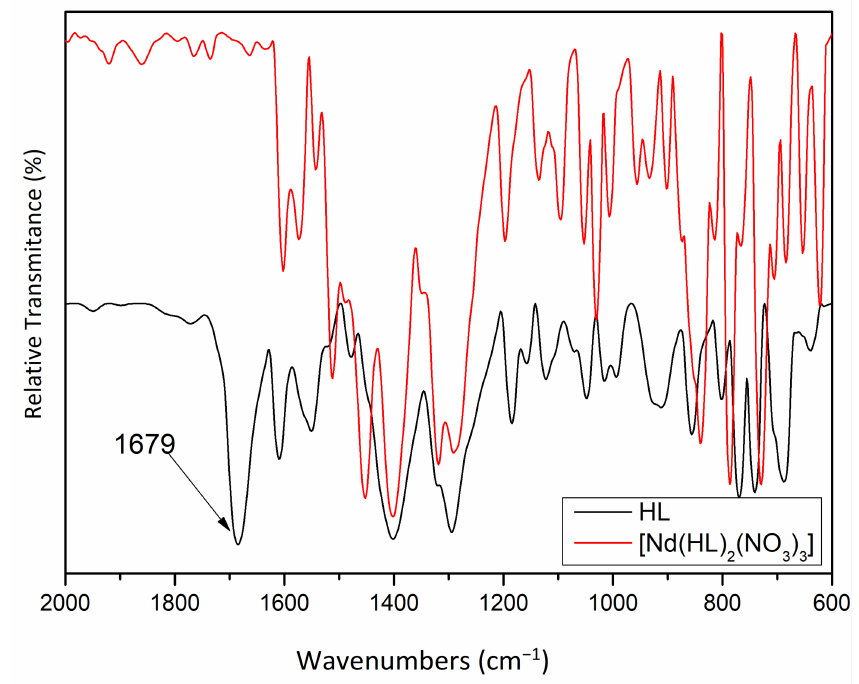
Figure 1. IR-spectra of HL and [Nd(HL) 2 (NO 3 ) 3 ]